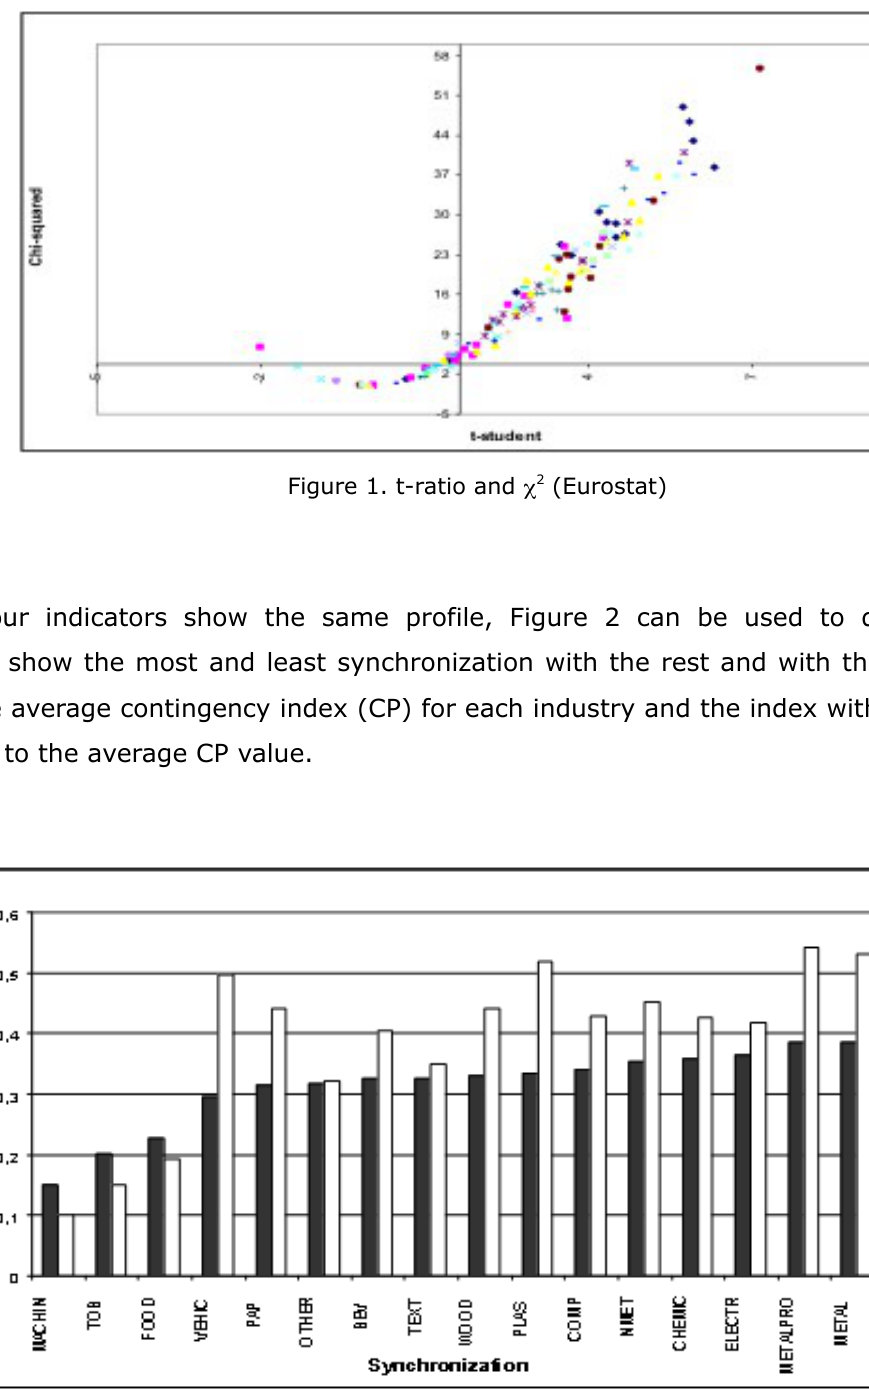
Figure 2. Average CP and CP for each industry with the BC